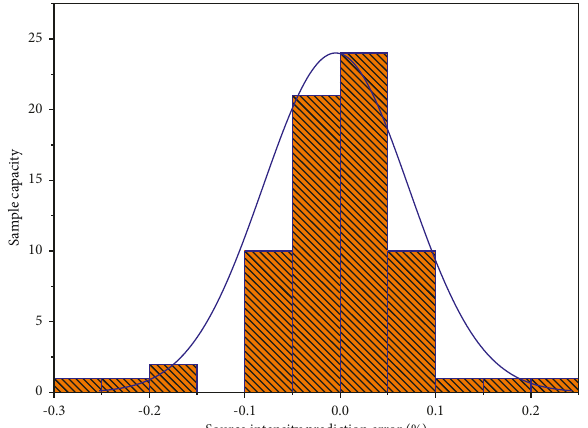
Figure 12: Source intensity prediction error distribution predicted by